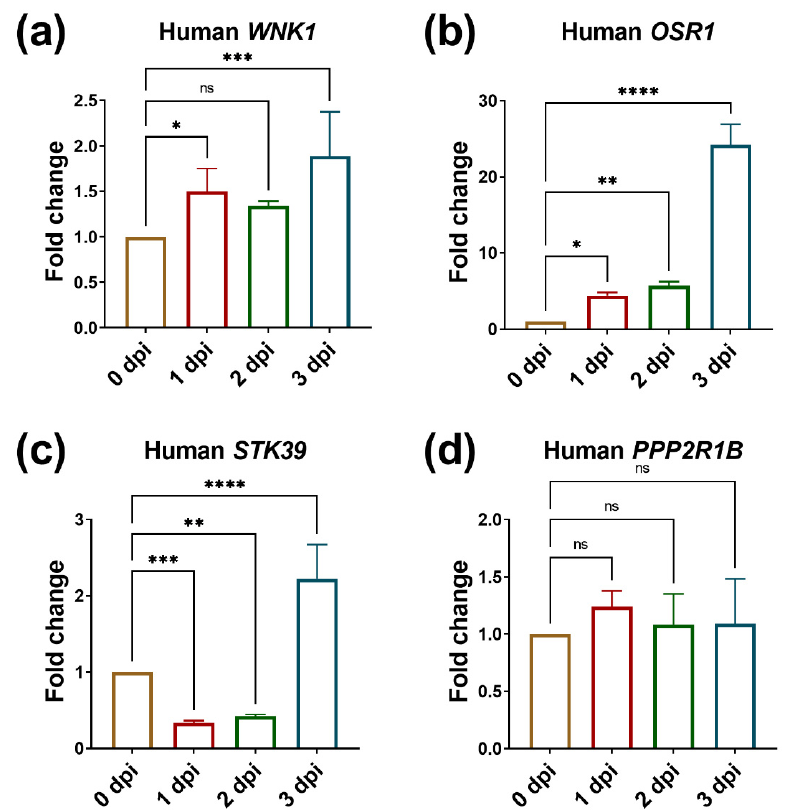
Figure 4. The expression of WNK1 and OSR1 is upregulated in hepatoma cells during tumor-induced angiogenesis promoting hepatoma cell proliferation. The expression of WNK1 and its downstream effectors in hepatoma cells during tumor induced angiogenesis. ( a ) WNK1 , ( b ) OSR1 , ( c ) STK39 , ( d ) PPP2R1B in zebrafish embryos carrying hepatoma cells from 0 dpi to 3 dpi during tumor-induced angiogenesis. We performed three to four replicates, and for each qPCR, there were triplicates for each sample. Thirty embryos were included in each experiment. One-way ANOVA analysis followed by multiple analysis was used to identify the statistical significance between groups. *: p (cid:53) 0.05; **: p (cid:53) 0.01; ***: p (cid:53) 0.001; ****: p (cid:53) 0.0001; ns: